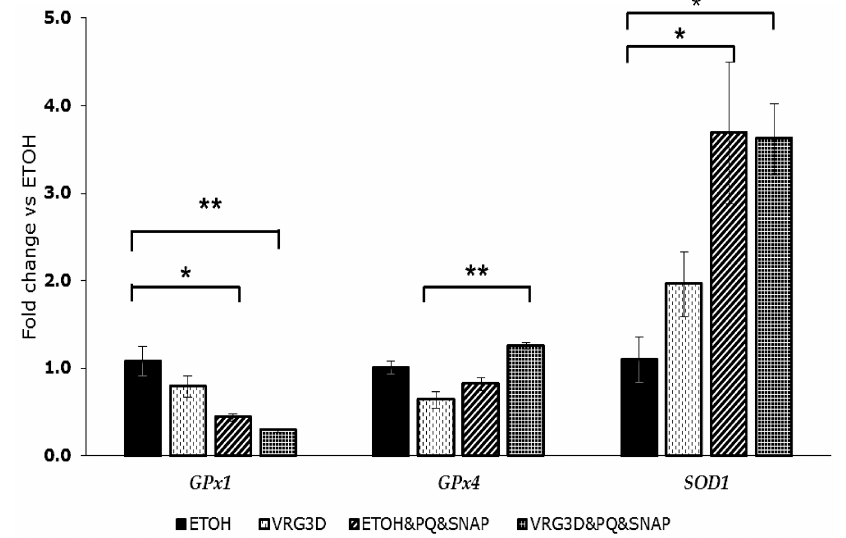
Figure 4. Effect of 3-day-germinated mung bean extract on antioxidant enzymes gene expression. Results are represented as means ± SEM. * indicates a significance of p < 0.05; ** indicates a significance of p < 0.01. ETOH, ethanol. VRG3D, 3d-germinated Vigna radiata . ETOH&PQ&SNAP, ethanol plus PQ / SNAP. VRG3D&PQ&SNAP, 3d-germinated Vigna radiata plus PQ / SNAP. PQ, Paraquat . SNAP, S-nitroso-N-acetylpenicillamine .